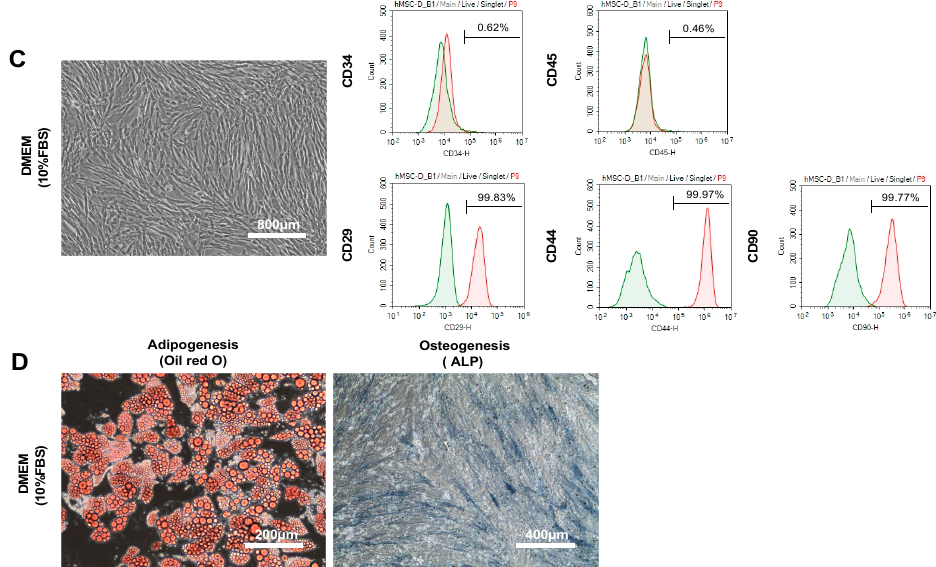
Figure 1. Phenotype and differentiation potential of hADSCs in culture chemically defined medium (CDM) or Dulbecco’s Modified Eagle’s medium (DMEM). The morphological appearance of CDM human Adipose tissue-derived mesenchymal stem cells (hADSCs) (( A ), left panel) and cell surface markers of CDM hADSCs by flow cytometry. n = 3 (( A ), right panels). Representative images of adipocyte. n = 3 (( B ), left panel) and osteocyte differentiation. n = 3 (( B ), right panel) from CDM hADSCs cultured in differentiation medium. The morphological appearance of DMEM hADSCs (( C ), left panel) and cell surface markers of DMEM hADSCs by flow cytometry. n = 3 (( C ), right panels). Representative images of adipocyte. n = 3 (( D ), left panel) and osteocyte differentiation. n = 3 (( D ), right panel) from DMEM hADSCs cultured in differentiation medium.